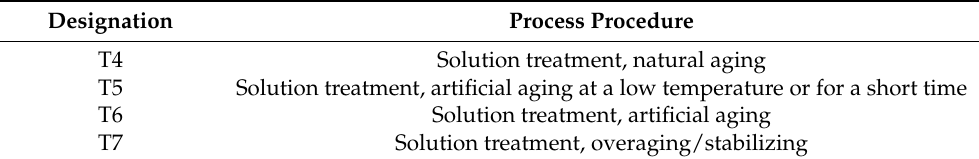
Table 4. Commonly used aging treatment for aluminum alloys